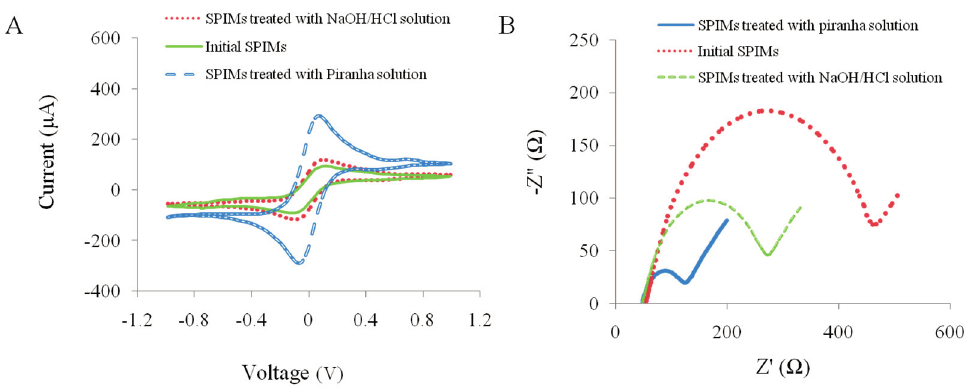
Figure 1. Characterization of the SPIMs by cyclic voltammetry (CV) and electrochemical impedance spectroscopy (EIS) after the washing with piranha solution and NaOH/HCl solution. ( A ) the current change; and ( B ) the impedance change.